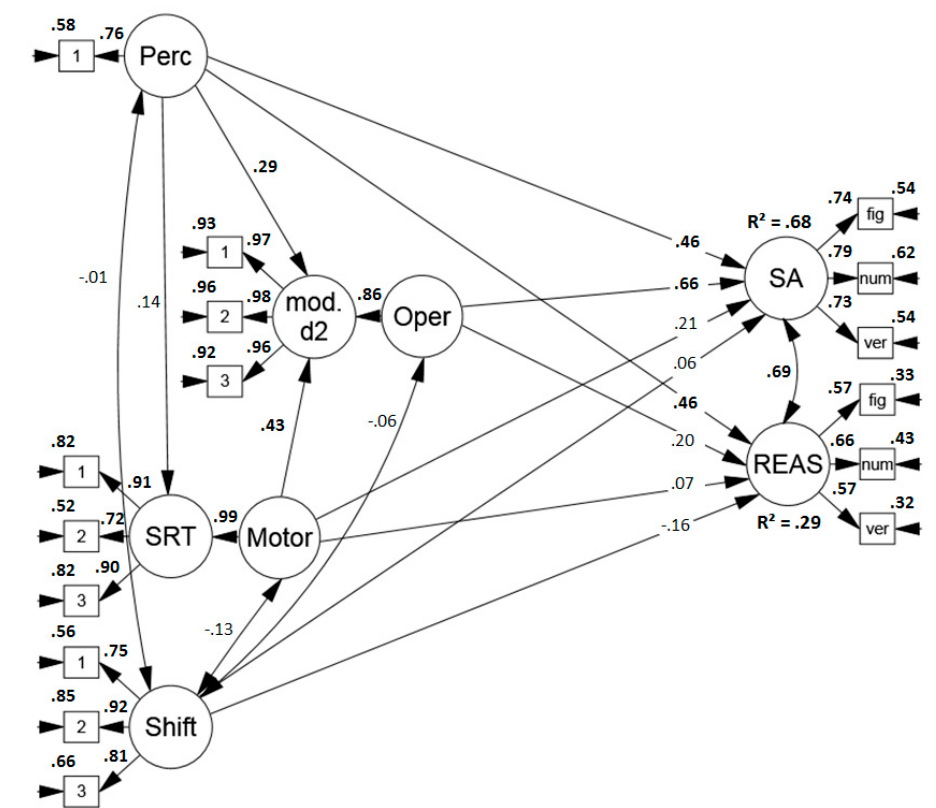
Figure 6. Standardized solution of the model predicting performance in sustained attention tests (convergent validity) and performance in reasoning tests (discriminant validity). Significant results are printed in boldface. Perc = perceptual speed, mod. d2 = modified d2, Oper = operation speed, SRT = simple reaction time task, Motor = motor speed, Shift = item shifting speed, SA = sustained attention, REAS = reasoning, fig = figural task, num = numerical task, verb = verbal task.